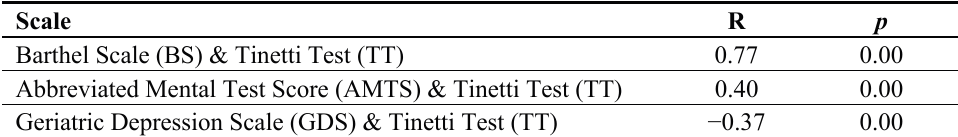
Table 9. Multifactor analysis-factors contributing to the occurrence of falls.